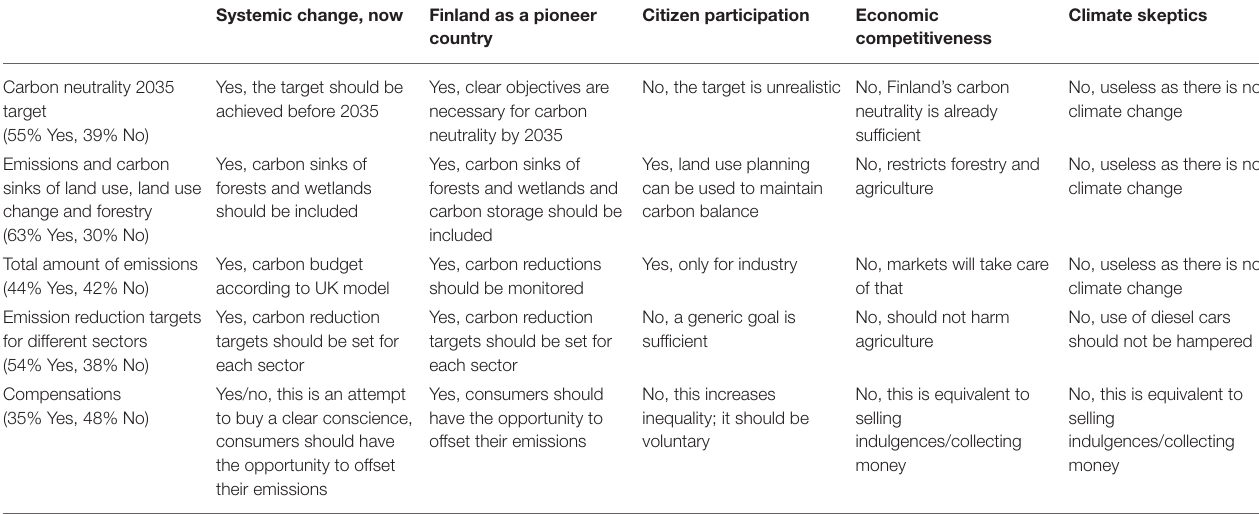
TABLE 2 | Public perceptions of the objectives of the Finnish Climate Change Act amendment. Systemic change,